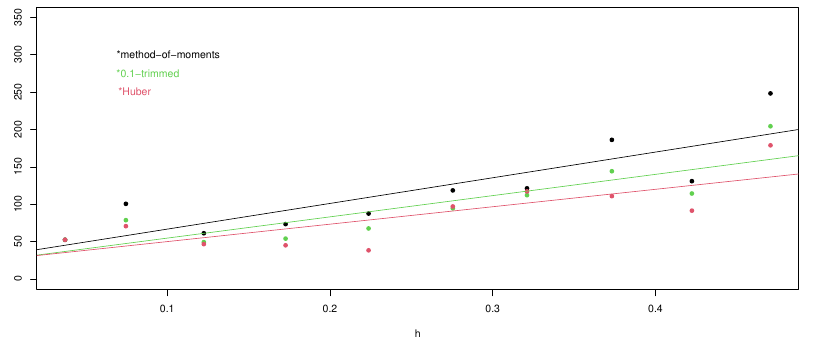
Figure 11. Classical (black) and robust (green and red) cross-variogram estimations of Example 3, with the linearized cross-variogram